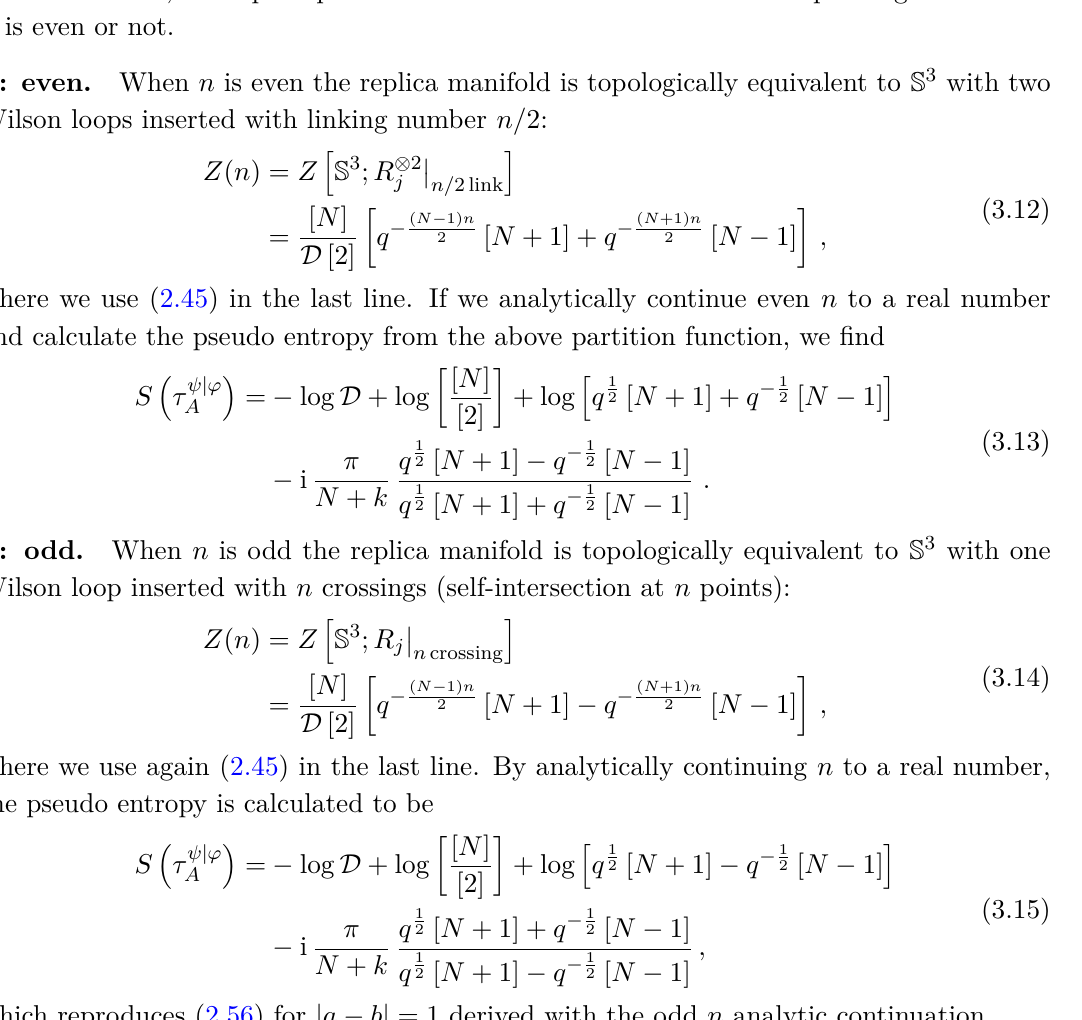
Figure 14 . The path integral representation of the transition matrix τ ψ | ϕ excitations, one in the fundamental representation and the other in the anti-fundamental represen- tation inside A